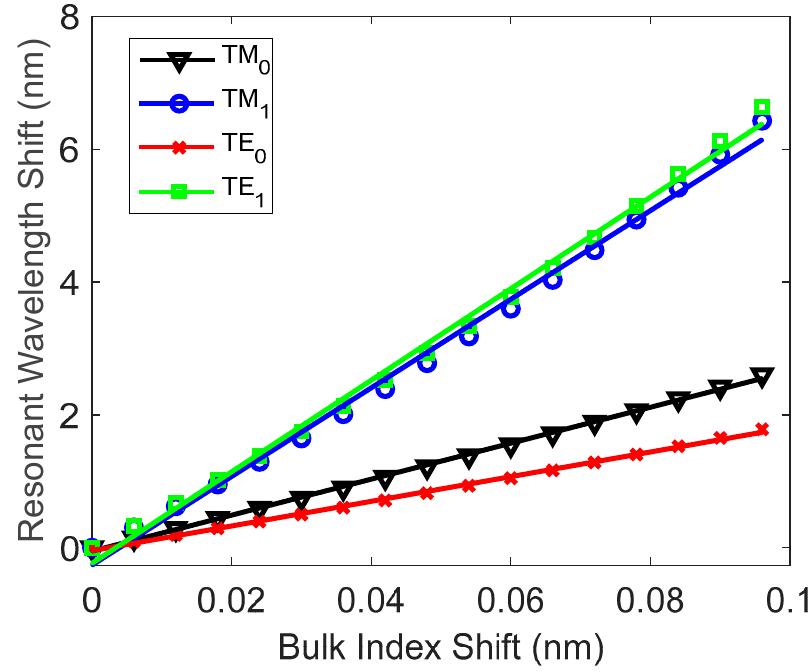
Figure 4. Simulated bulk index of refraction shifts and the resultant resonant wavelength shifts for the TM and TE resonant modes: the biolayer thickness for these simulations is 0 nm. Each resonant mode is plotted with its best fit line of corresponding color.